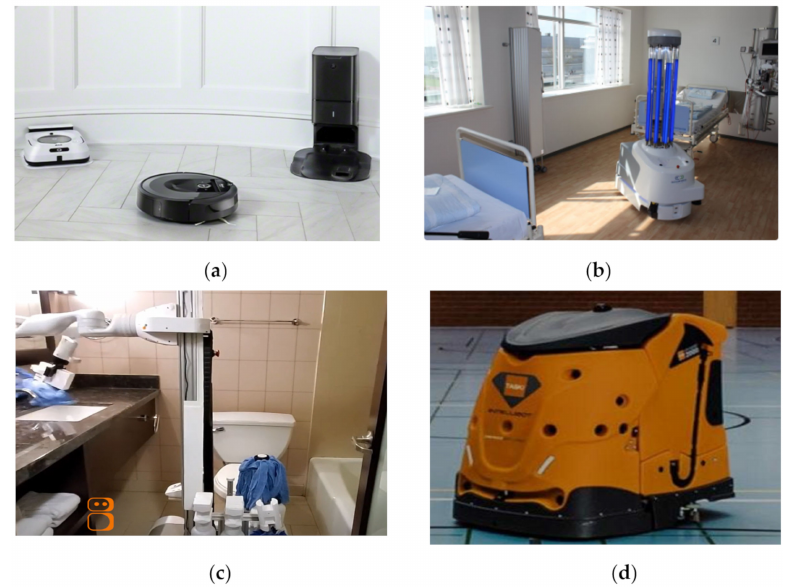
Figure 9. Cleaning and mopping robots in hospitals. ( a ) Roomba i7 cleaning robot [54]. ( b ) UVD robot for disinfecting hospital premises [55]. ( c ) Peanut robot for washroom cleaning [56]. ( d ) Swingobot 2000 cleaning robot [57].